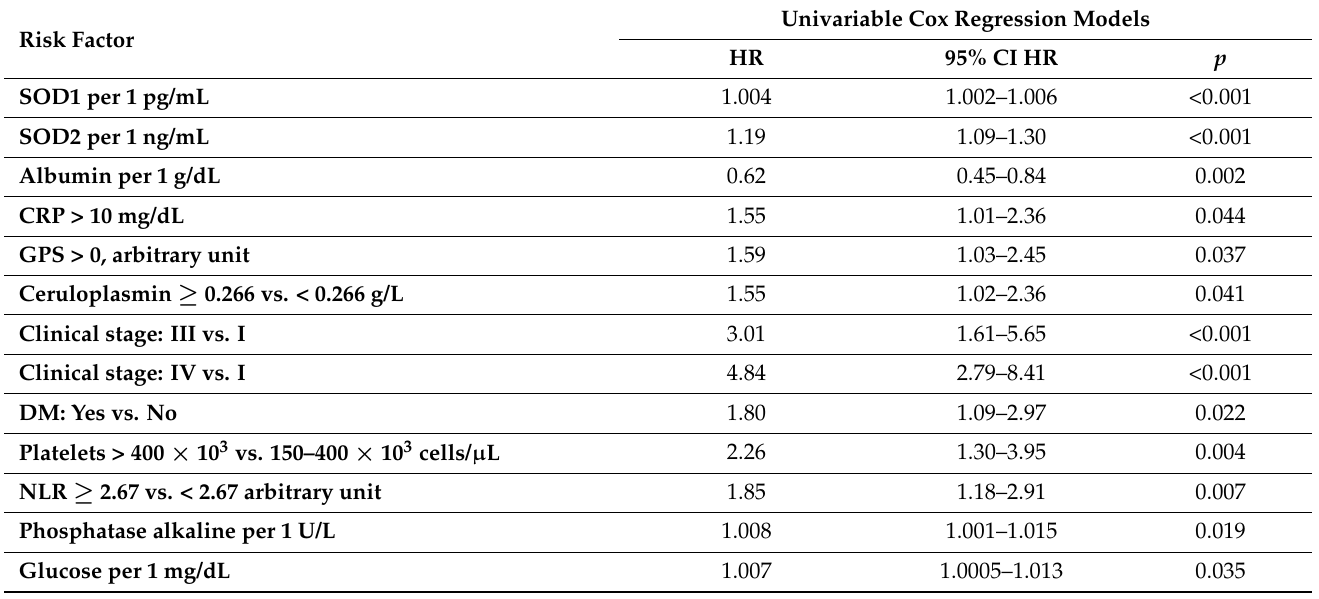
Table 3. Univariate Cox regression models in predicting lung cancer